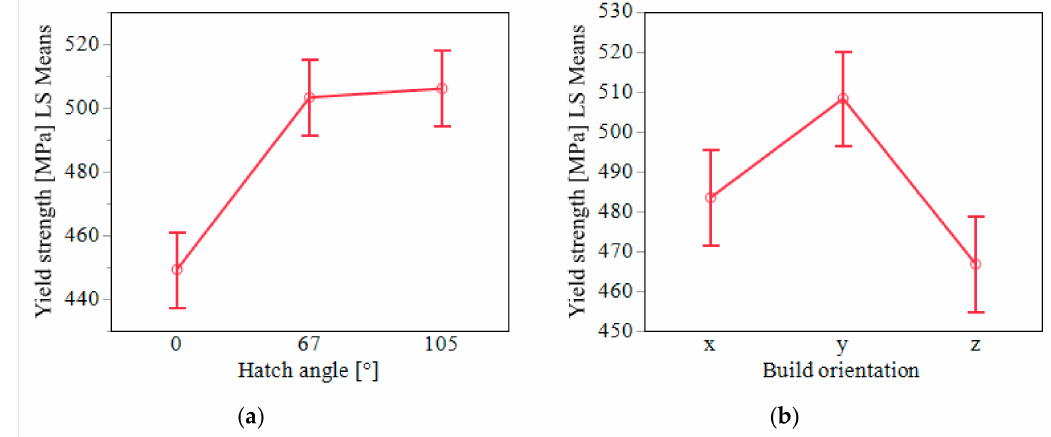
Figure 11. Least square mean plot (yield strength) for the two factors: ( a ) hatch angle, and ( b ) build orientation.